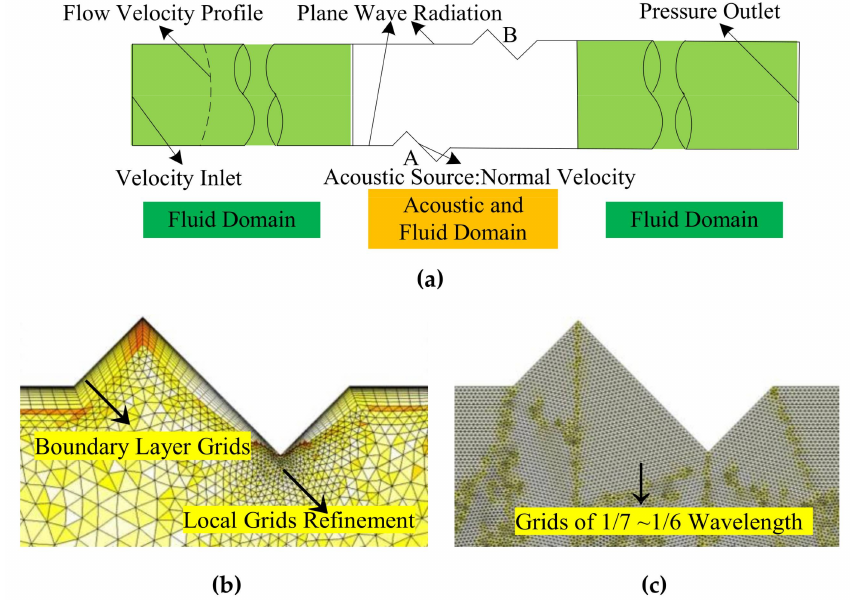
Figure 3. Physical field and grids settings. ( a ) Physical field settings. ( b ) Grid settings for the fluid domain. ( c ) Grid settings for the acoustic